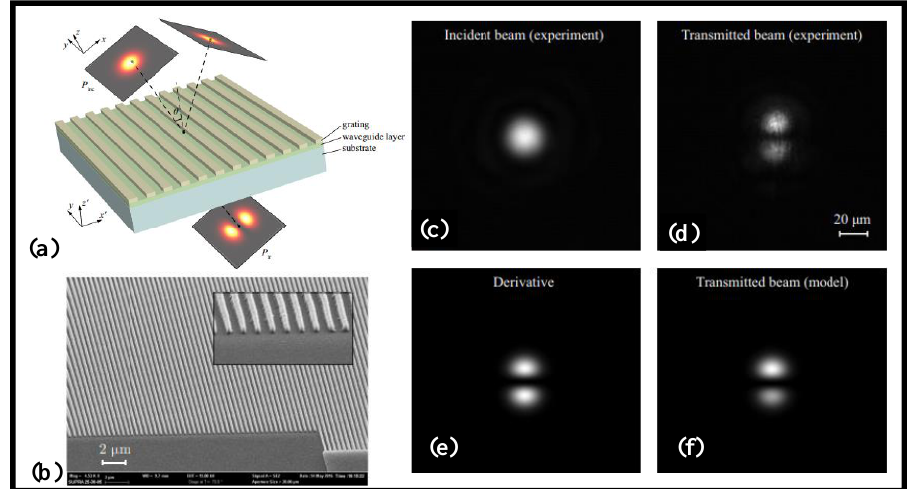
Figure 8. ( a ) The diffraction of an optical light wave on a resonant diffraction assembly made up of a grating on top of a slab waveguide layer put on a substrate [188], ( b ) The diffraction grating was created using ERP-40 electron resist on top of a TiO 2 layer, as shown by SEM [188], ( c ) Measured profile of incident Gaussian light wave [188], ( d ) Measured profile of transmitted light wave [188], ( e ) Analytically derived derivative of incident light wave [188], ( f ) Profile of transmitted light wave estimated taking into account manufactured structural flaws